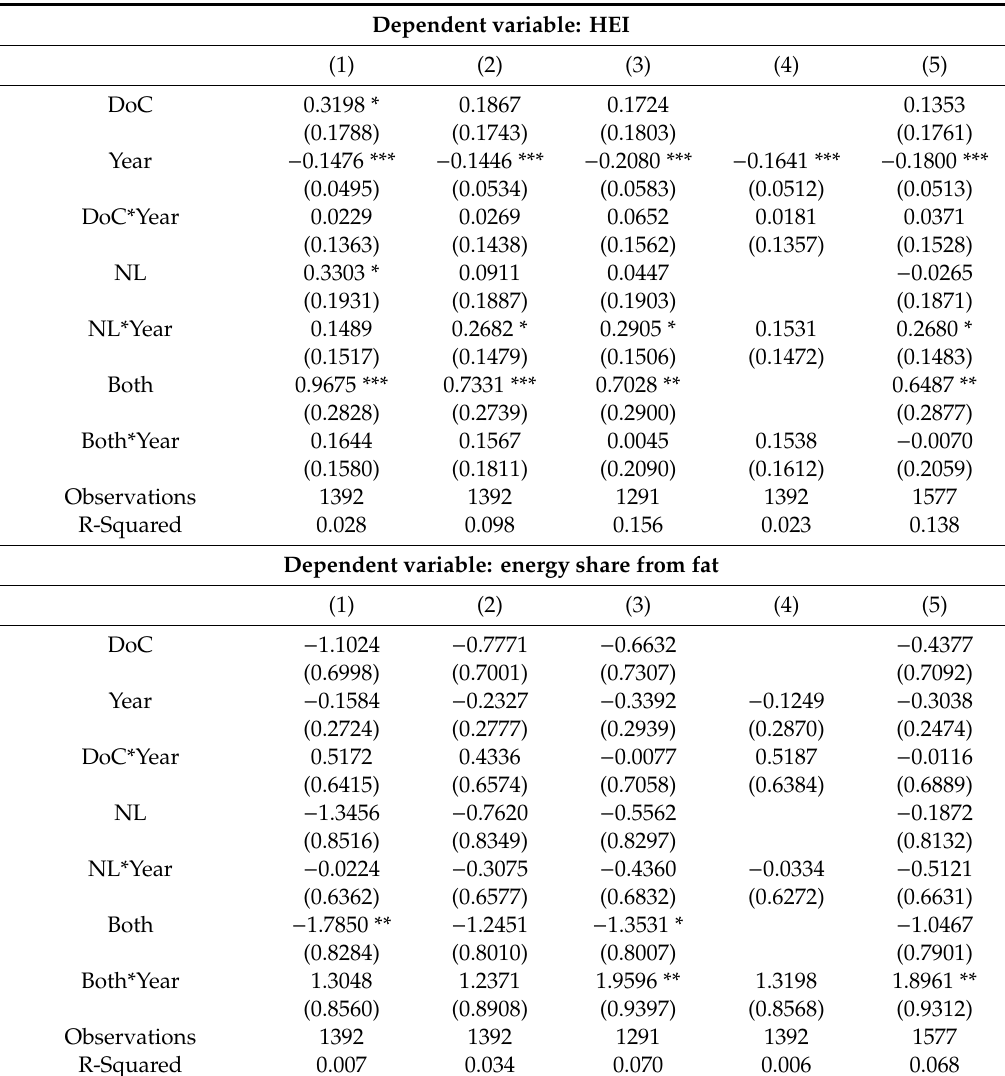
Table 8. Di ff erence-in-di ff erence for NL, DoC and